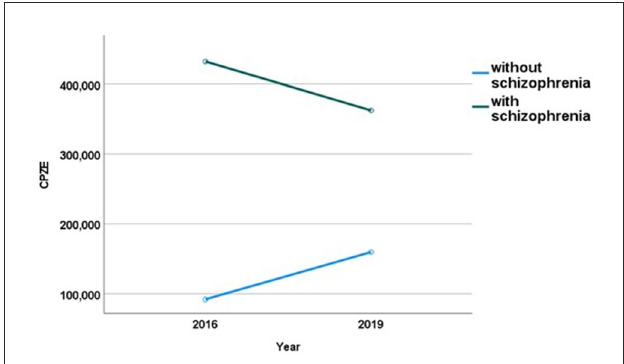
FIGURE1 Mean medication dosage in chlorpromazine equivalents (CPZE) at discharge before (2016) and after (2019) the implementation of